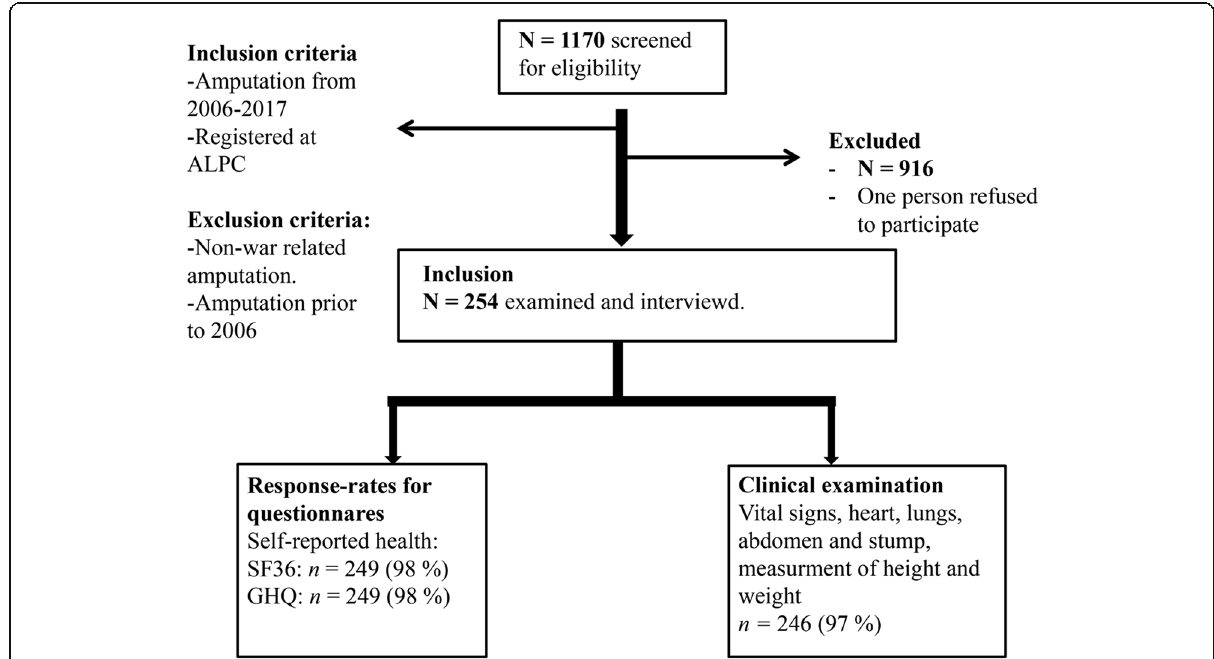
Fig. 1 Inclusion of study participants. * N = 1170. ALPC: Artificial Limb and Polio Center, Gaza ’ s main rehabilitation clinic where patients were selected for